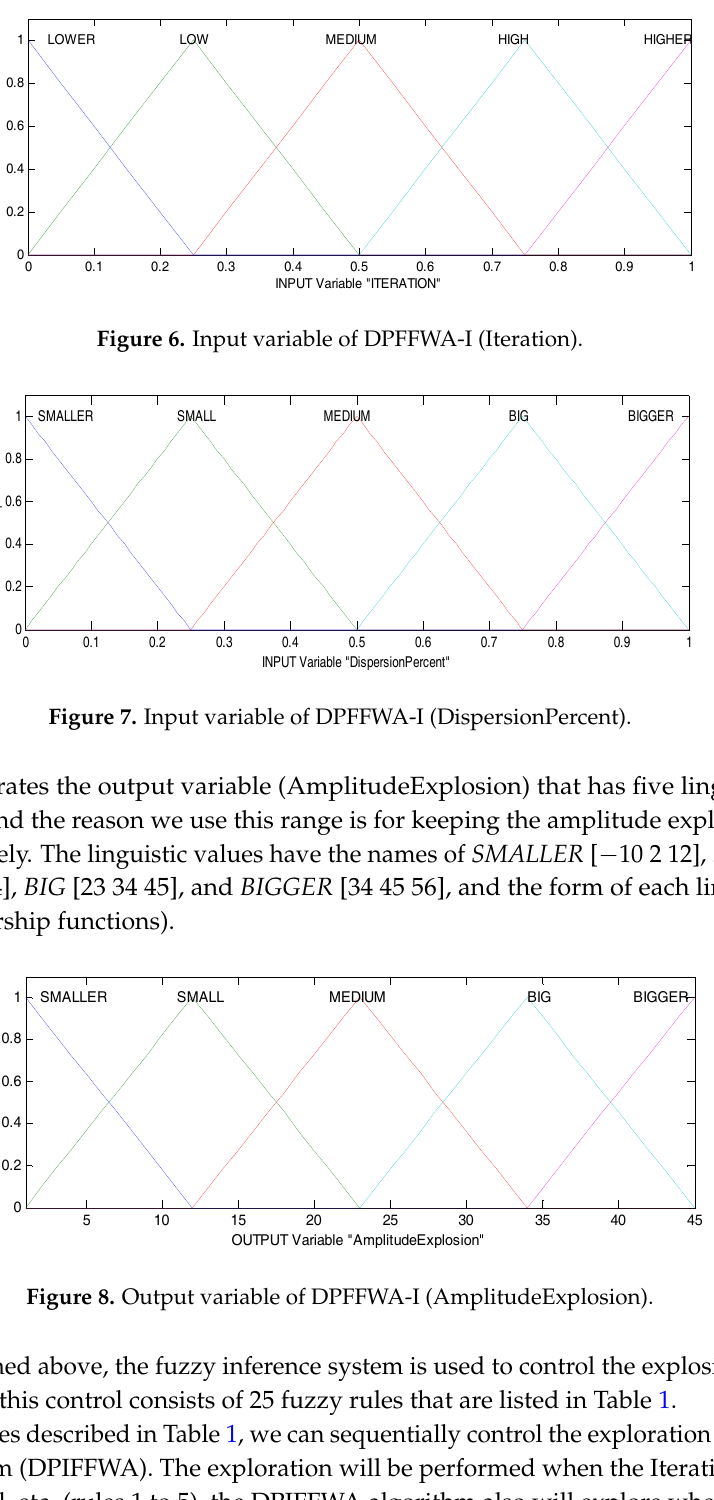
7 of 21 Figure 4. Requirement for dispersion percent ((cid:1830)(cid:1842)) . With the requirement for DP shown in Figure 4, we can obtain a value between 0 and 1; this value ( DP ) is an input variable of the fuzzy inference system (Figure 5), which is explained in more detail in the following sections. Another input variable is the “Iteration”, and to streamline and enhance the process of the fuzzy inference system and of course the general process of the algorithm, we normalized the input variable, which is called the Iteration; the normalization is calculated with the following equation [23]. (cid:1835)(cid:1872)(cid:1857)(cid:1870)(cid:1853)(cid:1872)(cid:1861)(cid:1867)(cid:1866) = (cid:1829)(cid:1873)(cid:1870)(cid:1870)(cid:1857)(cid:1866)(cid:1872) (cid:1835)(cid:1872)(cid:1857)(cid:1870)(cid:1853)(cid:1872)(cid:1861)(cid:1867)(cid:1866) (cid:1840)(cid:1873)(cid:1865)(cid:1854)(cid:1857)(cid:1870) (cid:1846)(cid:1867)(cid:1872)(cid:1853)(cid:1864) (cid:1835)(cid:1872)(cid:1857)(cid:1870)(cid:1853)(cid:1872)(cid:1861)(cid:1867)(cid:1866) (cid:1840)(cid:1873)(cid:1865)(cid:1854)(cid:1857)(cid:1870)